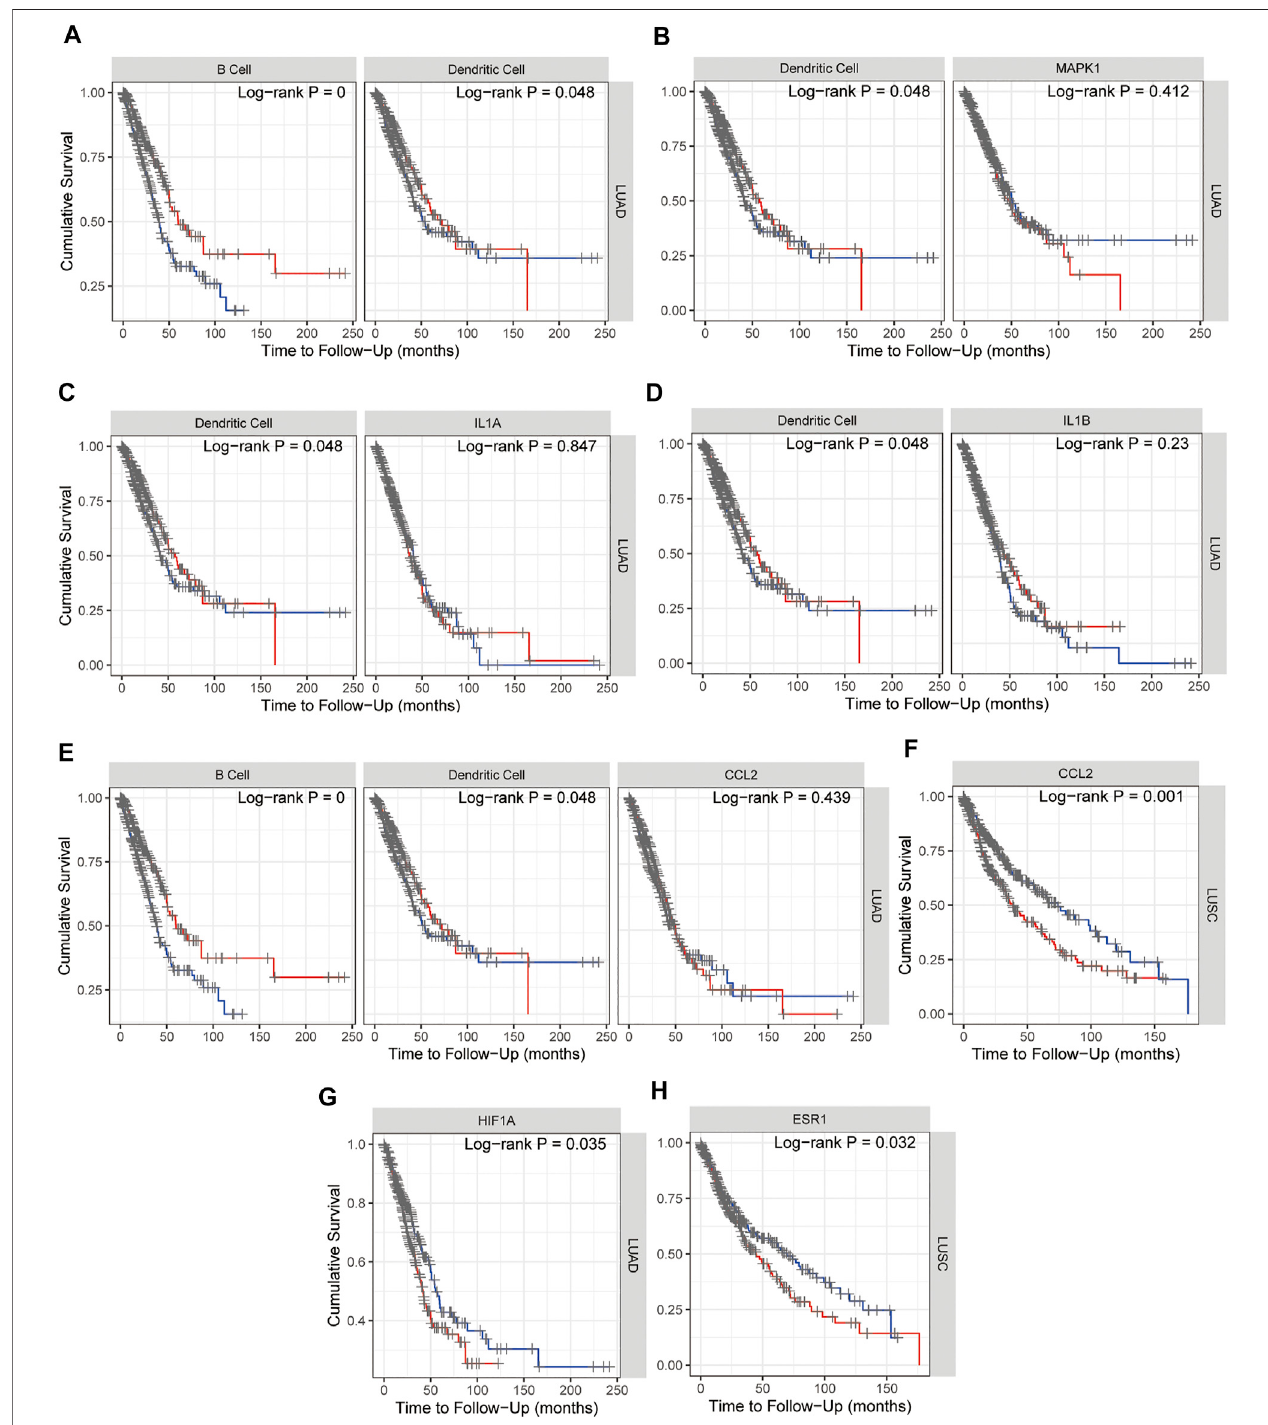
FIGURE 9 | Kaplan – Meier plots for immune in fi ltrates of lung adenocarcinoma (LUAD) and/or lung squamous cell carcinoma (LUSC) from TCGA (A) and MAPK1 (B) , IL1A (C) , IL1B (D) , CCL2 (E,F) , HIF1A (G) , and ESR1 (H) from 15 hub genes to visualize the survival differences. Levels are divided into low and high levels by 50% andtheredcurverepresentsthehightop50%whilethebluecurverepresentsthelowbottom50%.The p -valueofthelog-ranktestforcomparingsurvivalcurvesoftwo groups is shown in each plot, and p < 0.05 was considered signi fi cantly different.